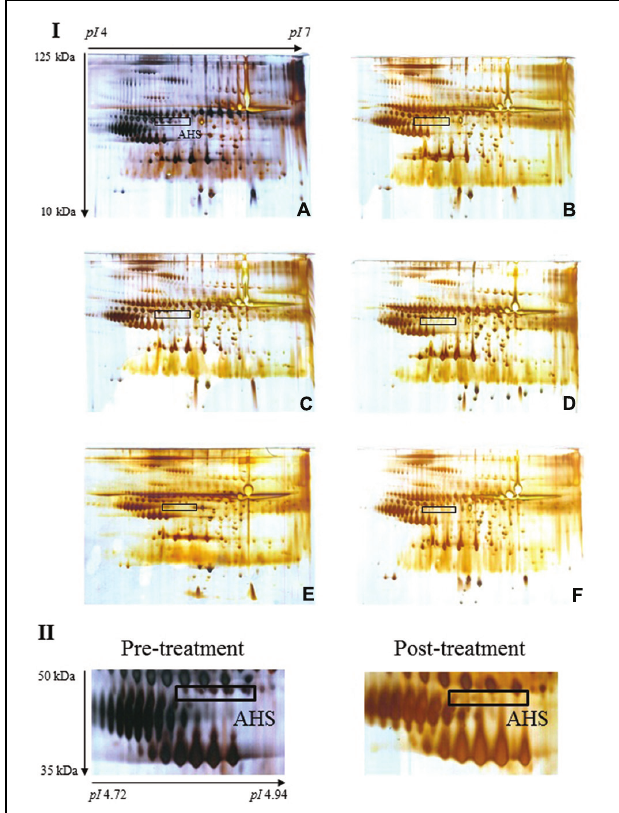
days 1, 7, 14, 21, and 28, respectively. The boxed protein cluster corresponds to AHS, which was lost in the serum samples from rats treated with